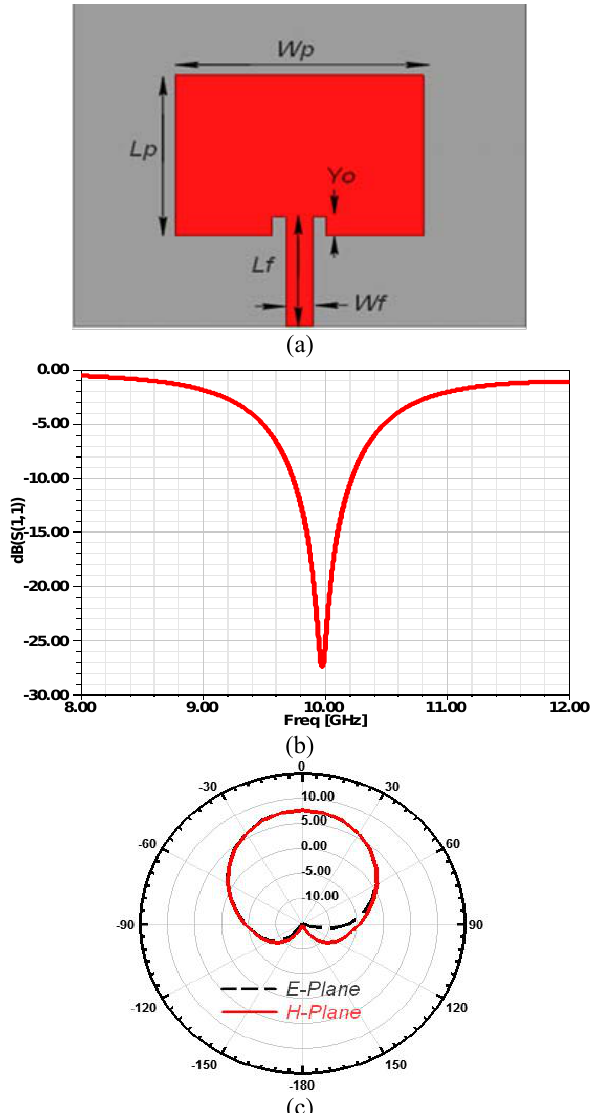
Figure 1: (a) Microstrip antenna operates at 10 GHz, (b) S 11 of the conventional microstrip antenna operates at 10 GHz, (c) Simulated E and H-planes radiation pattern at 10 GHz.